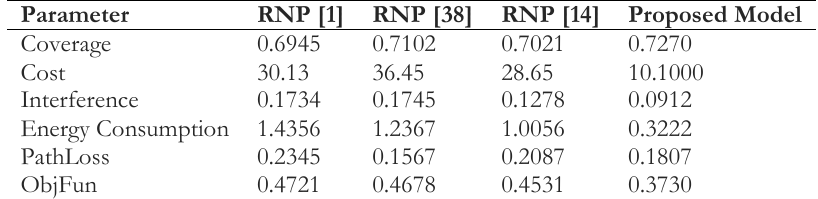
Table 15. Comparison of the proposed RNP model against the existing RNP models, for scenario 2.